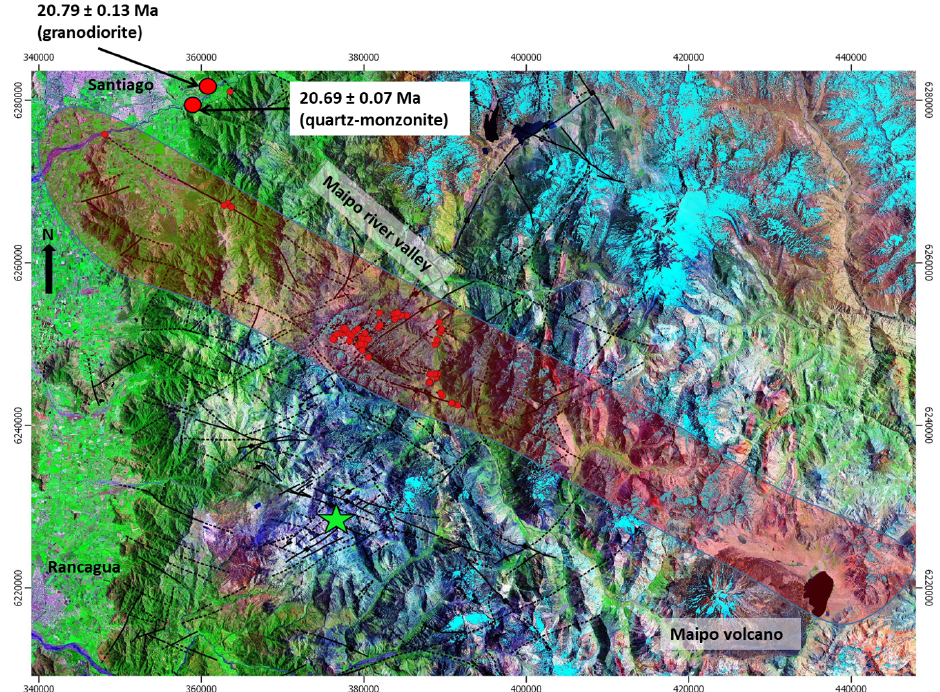
Figure 3. Distribution of structural stations (red dots) and sample location for U–Pb zircon ages. The semi-transparent red polygon shows the approximate extent of the PFS; the green star shows the location of the El Teniente porphyry Cu–Mo deposit. Black lines represent fault traces (continuous lines indicate the observed; dashed lines indicate the inferred). The background correspond to a Landsat image, courtesy of the US Geological